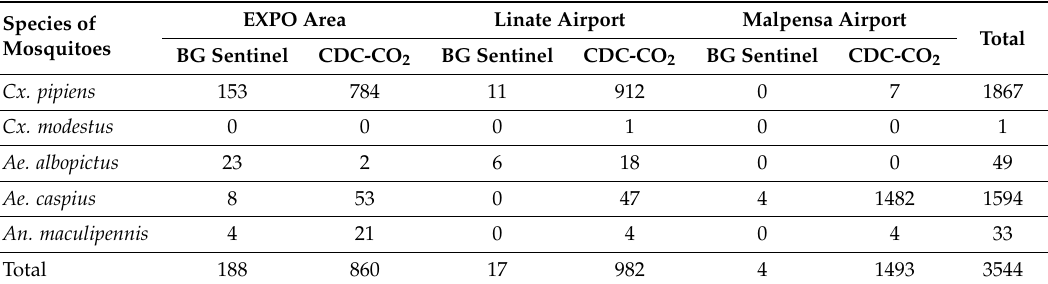
Table 1. Summary of the number and species of mosquitoes trapped during the surveillance activities in the EXPO framework. Fortnightly night-trap sessions were carried out in each of the three selected sites using BG Sentinel traps with BG-Lure attractant and CDC-CO 2 dry ice-baited traps. Species of